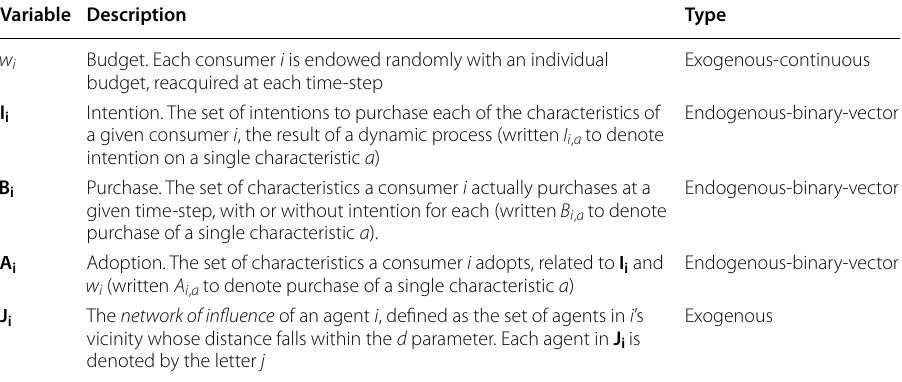
Table 1 Consumer variables, their description and type Variable Description